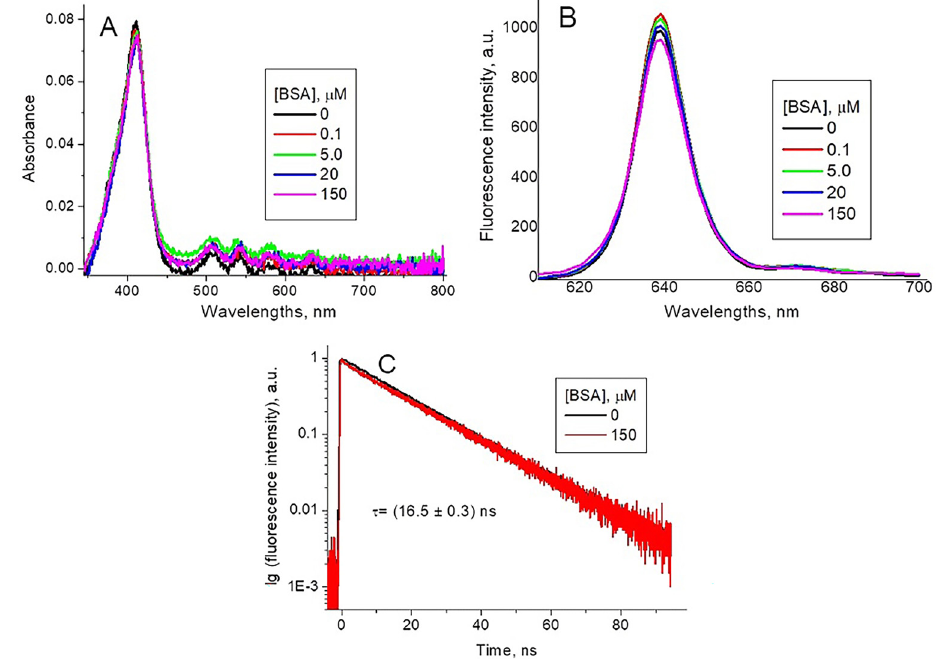
Figure 7. Optical absorption ( A ), fl uorescence spectra ( B ) ( l ex=409 nm), and fl uorescence decay curves ( C ) ( l ex=420 nm, l em= 637 nm) of endogenous protoporphyrin (PpIXe) at pH 4.5 for different bovine serum albumin (BSA)